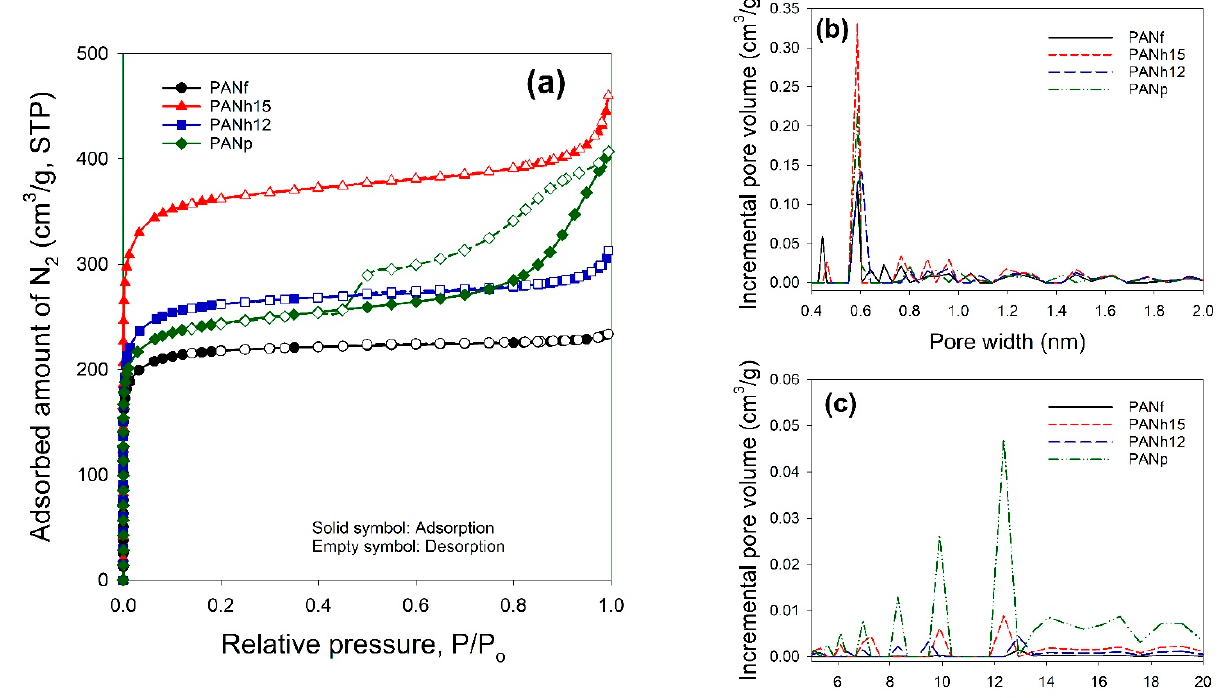
Figure 3. N 2 adsorption–desorption data at − 196 °C for the ACNFs: ( a ) isotherms; ( b ) pore size distributions (0.4–2 nm); ( c ) pore size distributions (5–20 nm).